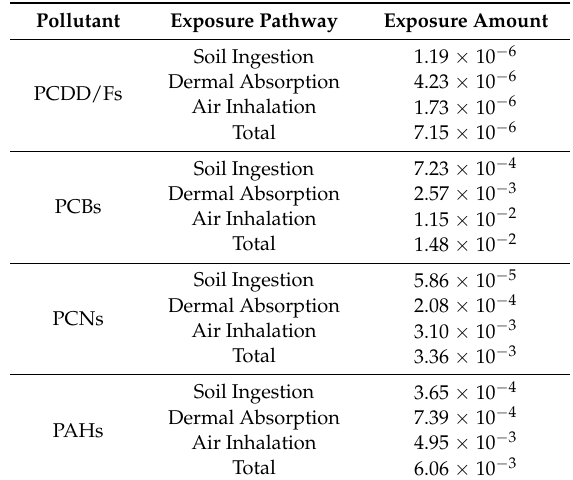
Table 7. Environmental exposure to PCDD/Fs (in ng WHO-TEQ/kg day), PCBs, PCNs (in ng/kg day) and PAHs (in µ g/kg day) through different pathways for adults living in Tarragona